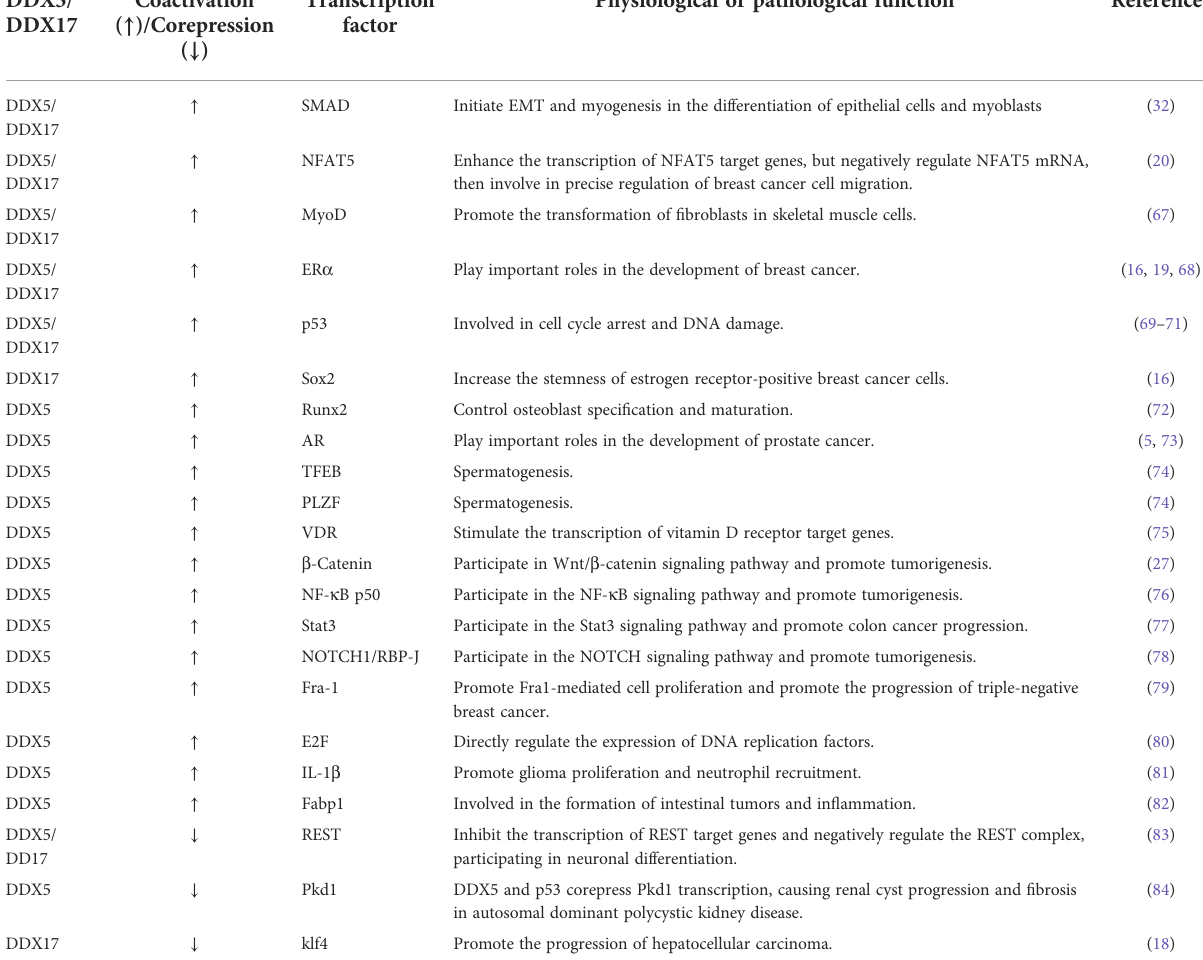
TABLE 1 DDX5/DDX17 coactivate or corepress transcription factor transcription. DDX5/